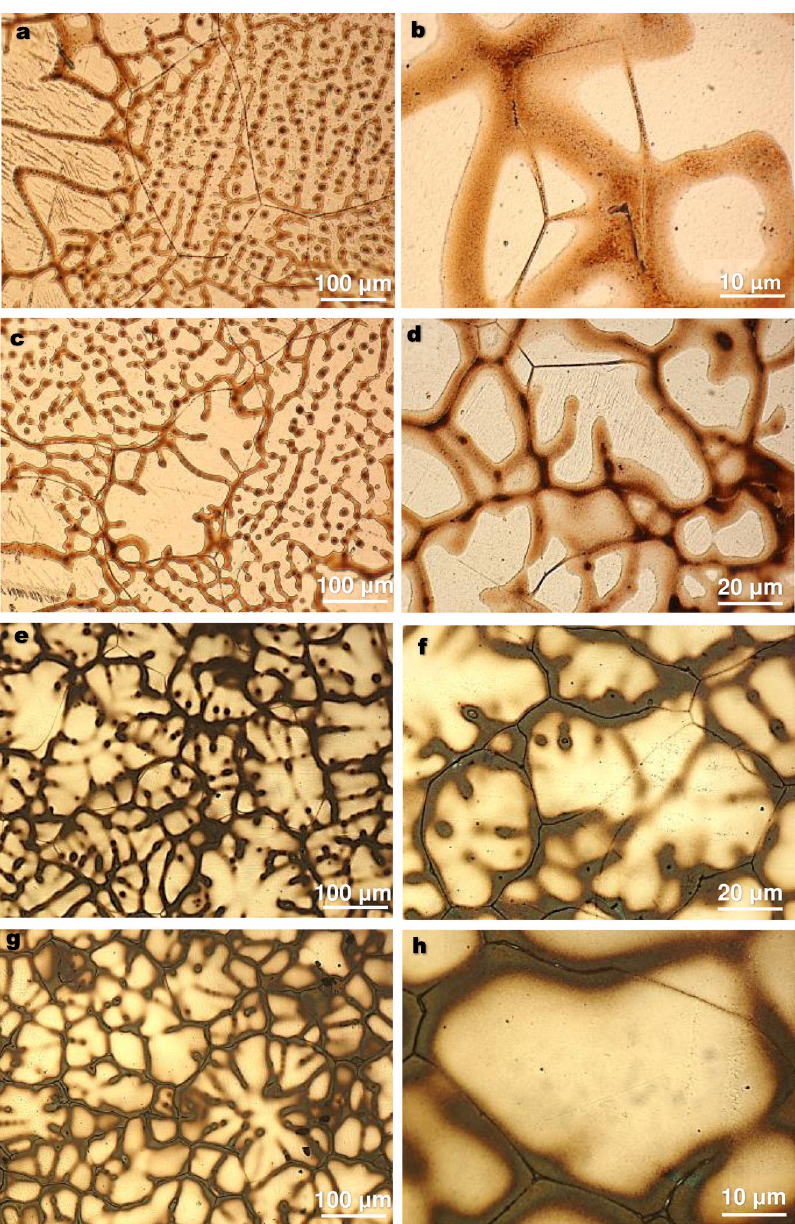
Fig. 3 | SGBM in as-cast Mg-Sn alloys with different solute contents. Left-hand- side:overviews;right-hand-side:closerviewsofSGBMfeatures. a , b Mg-0.21at.%Sn (1 wt.%Sn), extensive SGBM. c , d Mg-0.42at.%Sn (2 wt.%Sn), widespread